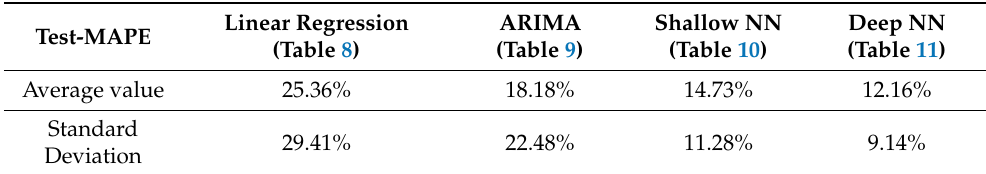
Table 12. Average value and standard deviation for the mean average percentage error on the test set corresponding to the sensitivity